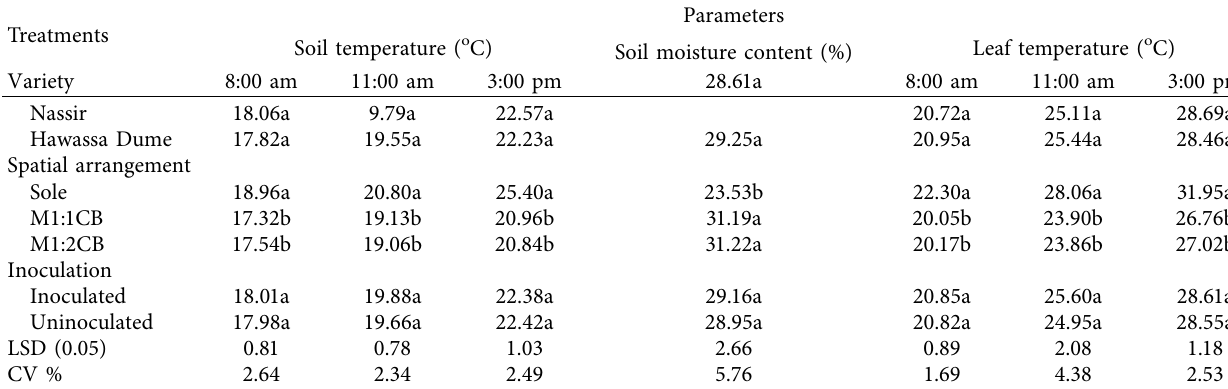
Table 4: Main efects of spatial arrangement on soil temperature ( o C), soil moisture content, and leaf temperature ( o C) at diferent time intervals of common bean.